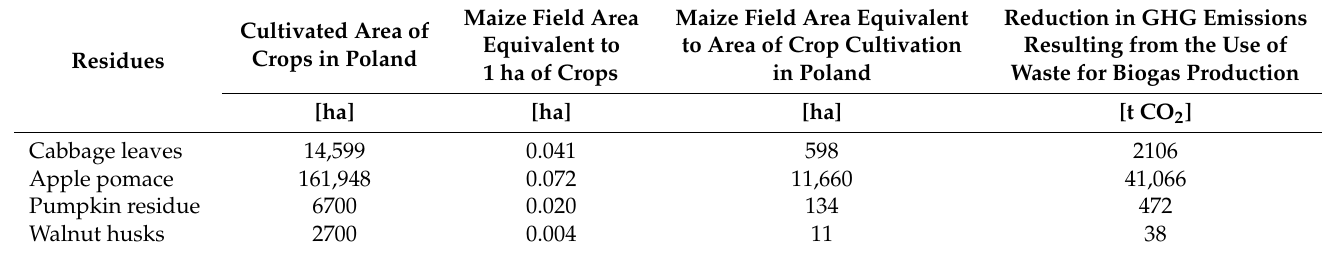
Table 4. The GHG reduction due to maize silage replacement with FVR in biogas